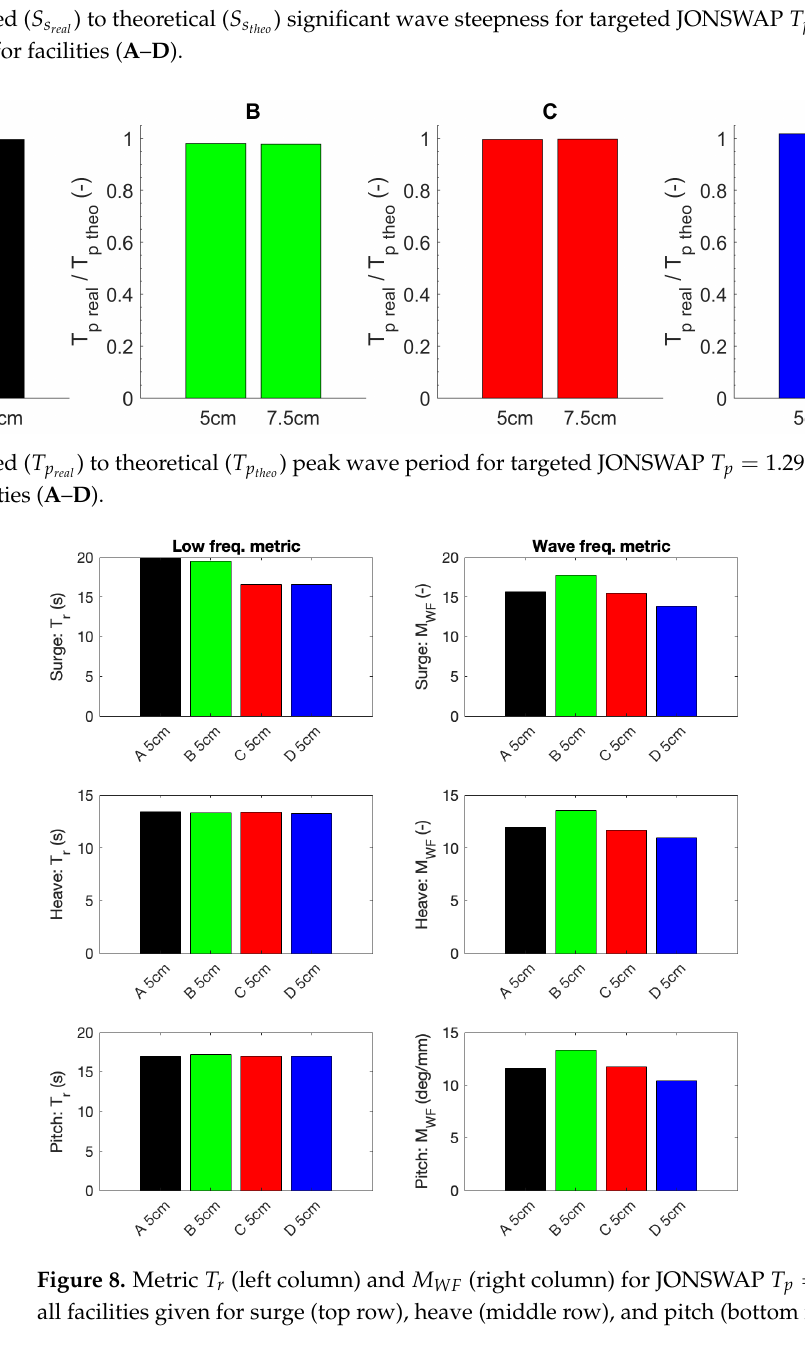
) to theoretical ( S s ) significant wave steepness for targeted JONSWAP T p = 1.29, H s = 5 real theo